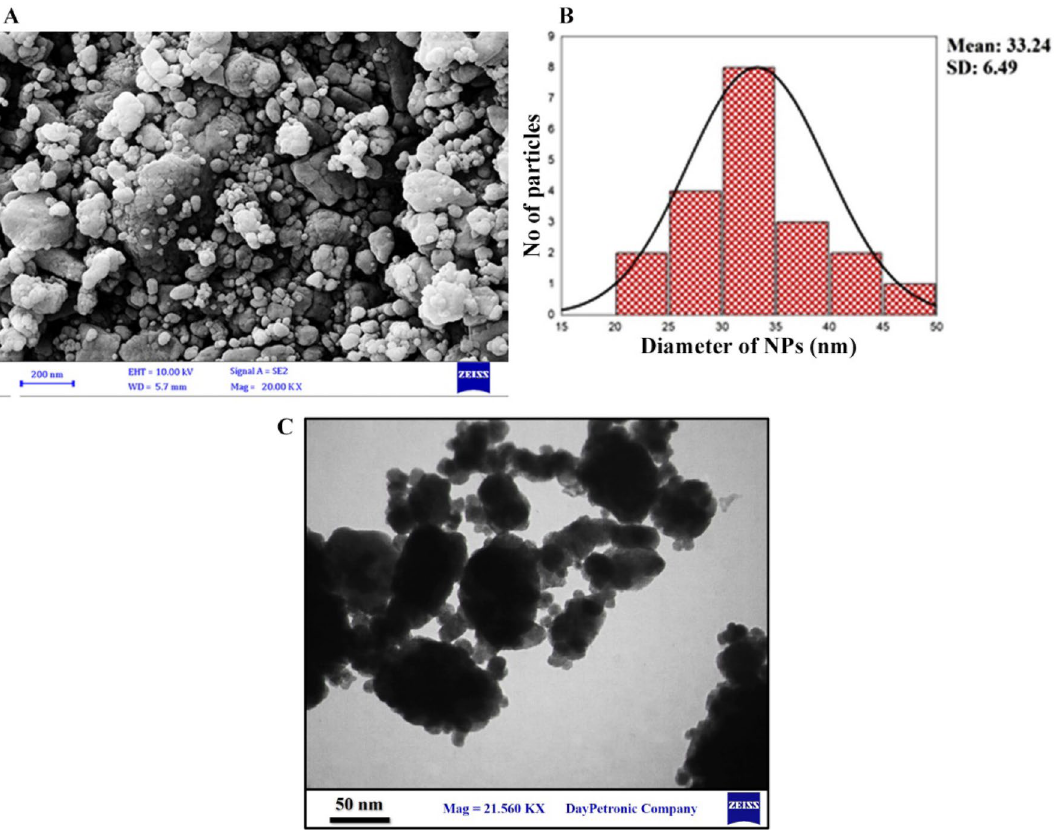
Figure 2. Structural and Morphological Properties of CuO NPs. ( A ) SEM image. ( B ) Diameter (nm) of CuONPs ranged between 33.24 ± 6.49 nm. ( C ) TEM